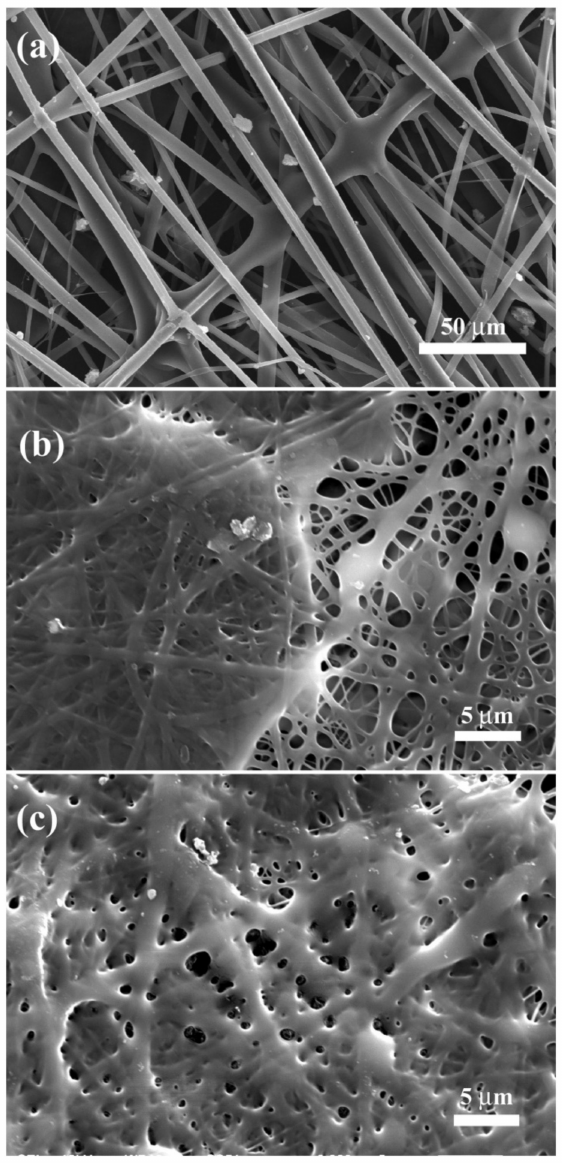
Figure 8. SEM images of the electrospun nanofiber mats produced from ( a ) pure gelatin; ( b ) gelatin/glycerol; ( c ) gelatin/glycerol/glucose. Reprinted from [97]. Copyright 2021 Elsevier. A higher temperature of 170–175 ◦ C, applied for 3 h was chosen by Siimon et al., who used gelatin type A from porcine skin, gelatin type B from bovine skin, and glucose